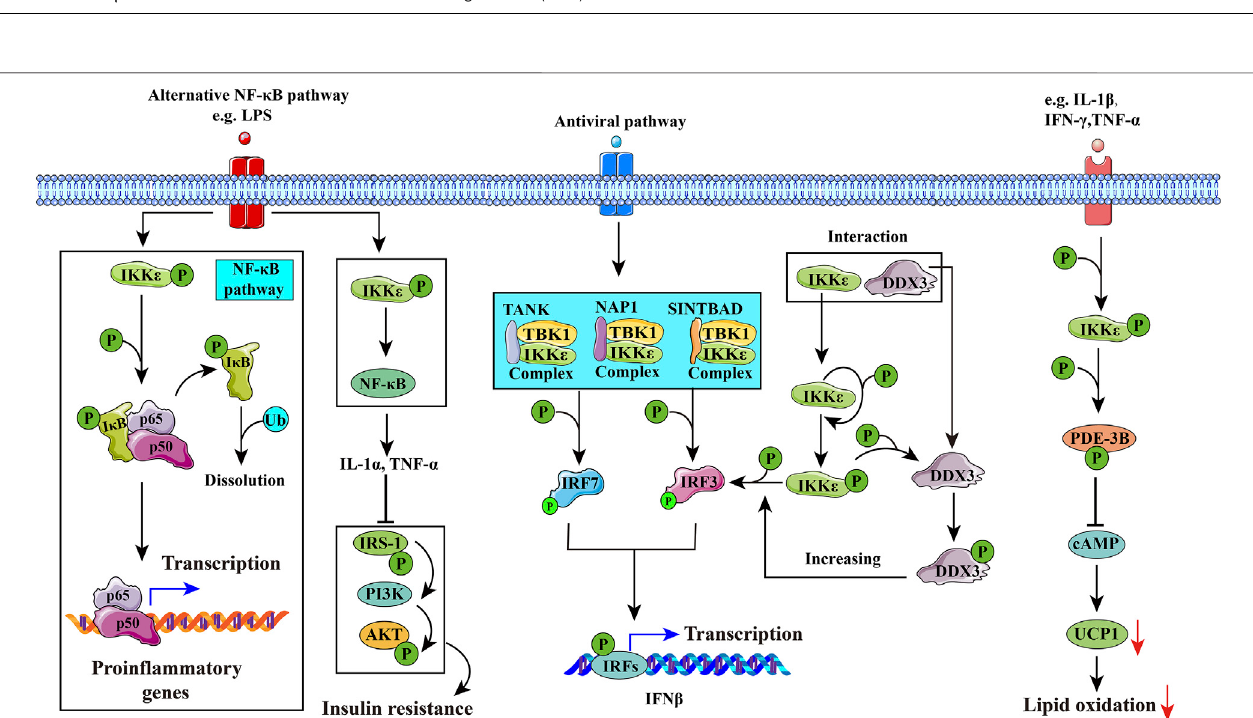
FIGURE 3 | Potential mechanisms of IKK ε in diseases. 1) IKK ε may induce in fl ammation through the NF- κ B pathway, leading to rheumatoid arthritis. 2) IKK ε in hepatic stellate cells (HSCs) activates the NF- κ B pathway to secrete cytokines such as IL-1 α , which inhibits the insulin signaling pathway in hepatic cells and interferes withglucoseandlipidmetabolism.3)IKK ε isinvolvedininnateimmuneresponsesbyphosphorylatinginterferonregulatoryfactor3(IRF3)andinterferonregulatoryfactor 7 (IRF7). DDX3 enhances the phosphorylation of IKK ε and promotes phosphorylation of IRF3, and eventually promotes IFN β promoter activation. 4) IKK ε is activatedbyPDE-3Bphosphorylatedatserine318.ActivatedPDE-3BreducescAMPcontentinadipocytesandinhibitsuncouplingprotein-1(UCP1)genetranscription, improving the resistance of adipocytes to catecholamines and inducing obesity.